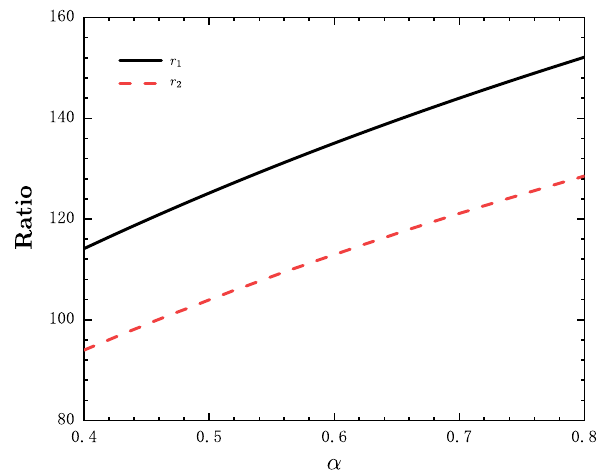
Fig. 6 The α -dependence of the ratios defined in Eq. (19) with m χ (cid:2) 3 . 872 GeV